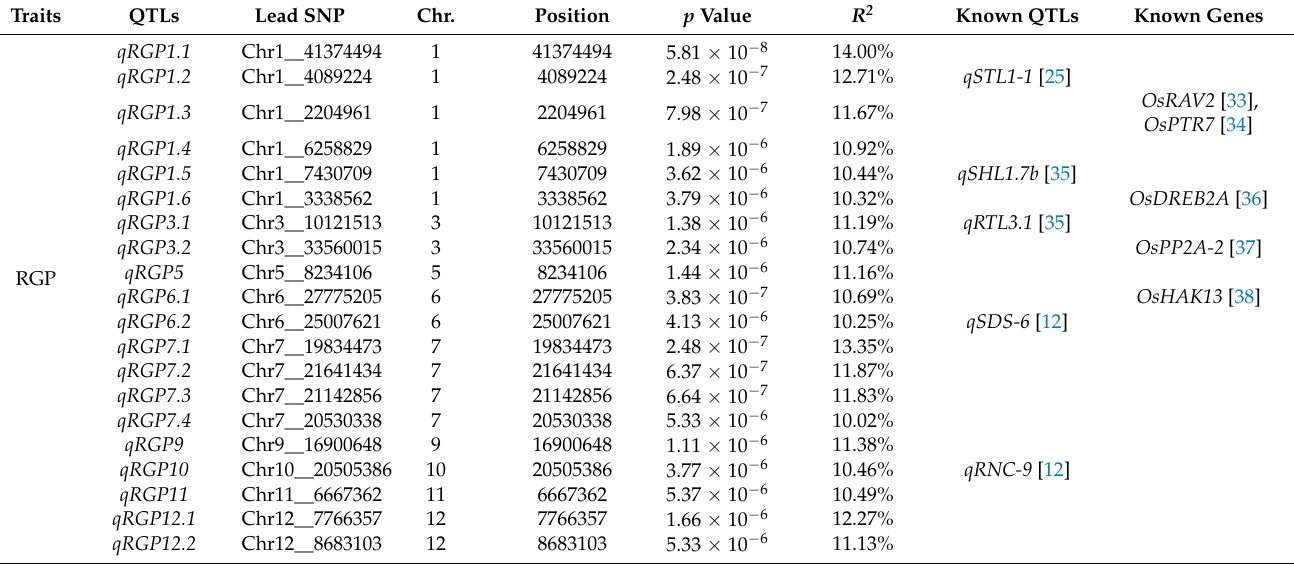
Figure 3. Manhattan plots and quantile–quantile (Q–Q) plots of GWAS for the salt tolerance. Red horizontal dashed line indicates the genome-wide significance threshold. ( a ) Manhattan plot for the RGP. ( b ) Q–Q plot for the RGP. ( c ) Manhattan plot for the RGI. ( d ) Q–Q plot for the RGI. Table 4. Chromosomal sites with significant correlation of salt tolerance traits during